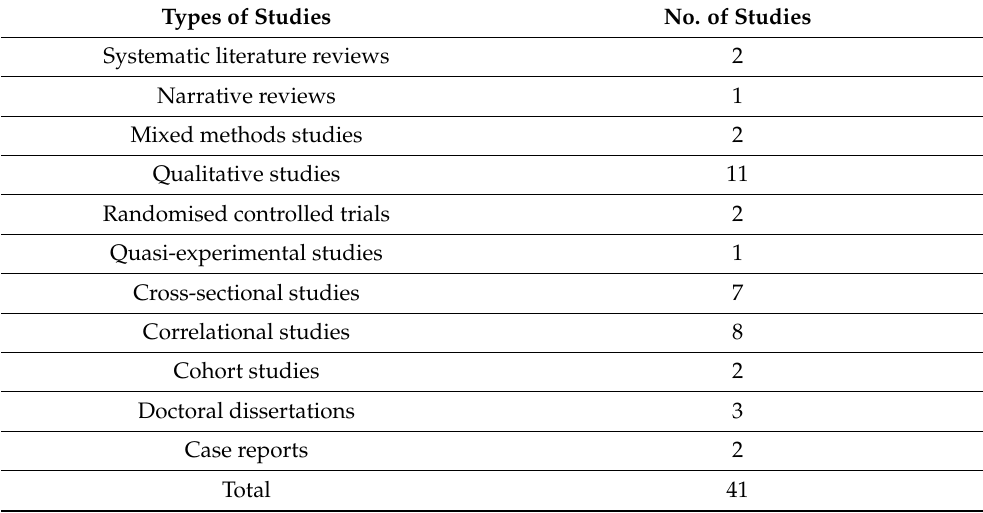
Table 2. Article